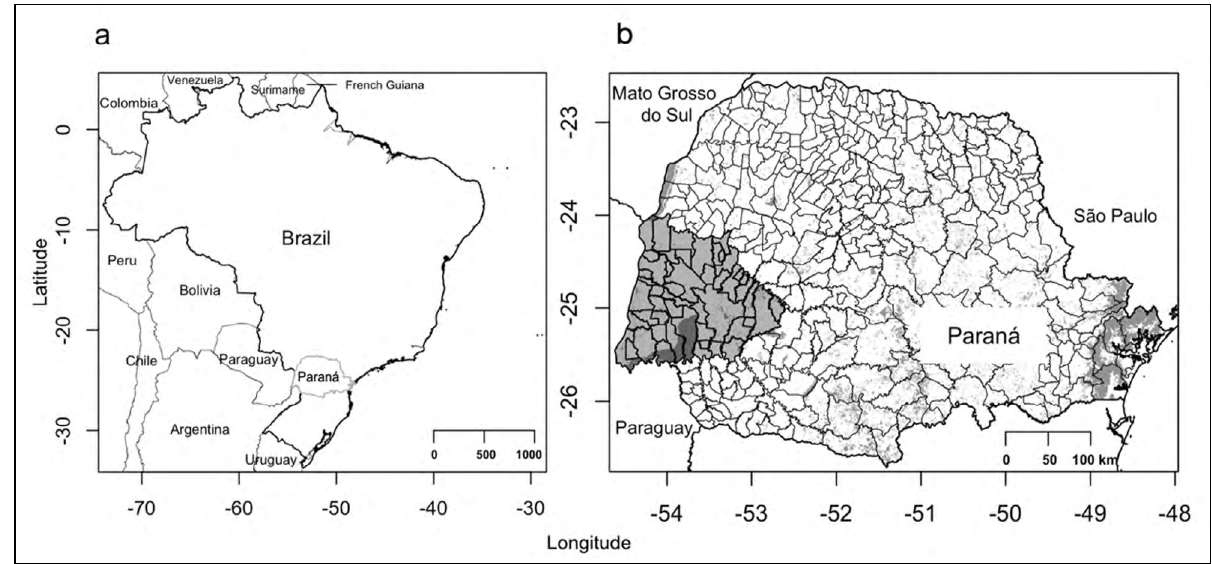
Figure 1 Maps illustrating the studied region in southern Brazil, with (a) the state of Paraná indicated in southern Brazil, and (b) the 50 municipalities in the state of Paraná where bird records were considered ( dark gray ). The remaining vegetation is shown in gray, including Iguaçu National Park ( darker gray , due to overlap), western